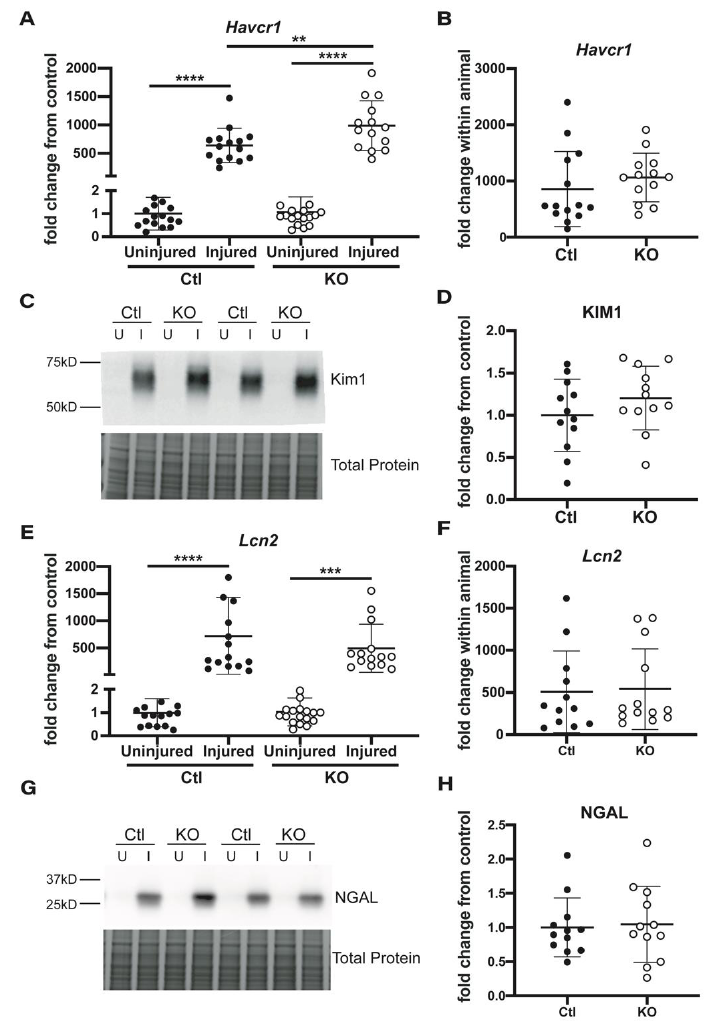
Figure 3. KIM-1 and NGAL expression in kidneys from mice subjected to IRI. ( A ) qPCR was per- formed to analyze the expression of Havcr1 message, the gene which encodes for KIM-1. Data were analyzed by the 2 - Ct method to determine fold change from the control, uninjured kidney. ( B ) These same data were analyzed in each individual mouse to determine Havcr1 expression in the kidney after injury, relative to the uninjured kidney. ( C ) Western blot was used to measure protein levels of KIM-1, with the representative blot illustrating noticeable expression in only the injured (I) kidneys of both control and knockout animals as compared to their uninjured (U) counterpart. Bands of interest were normalized to total protein as determined by a simultaneously run Coo- massie stained gel, with a representative portion shown. ( D ) Quantification of band density re- vealed no difference in KIM-1 protein expression between control and knockout injured kidneys. ( E ) qPCR was performed to analyze the expression of Lcn2 message, the gene which encodes for NGAL. Data were analyzed by 2 - Ct method to determine fold change from the control, uninjured